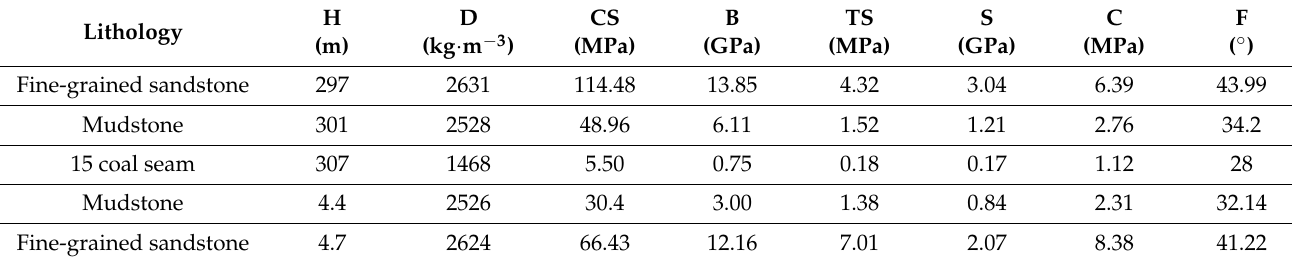
Figure 10. Numerical simulation model. Table 1. Mechanics parameters of